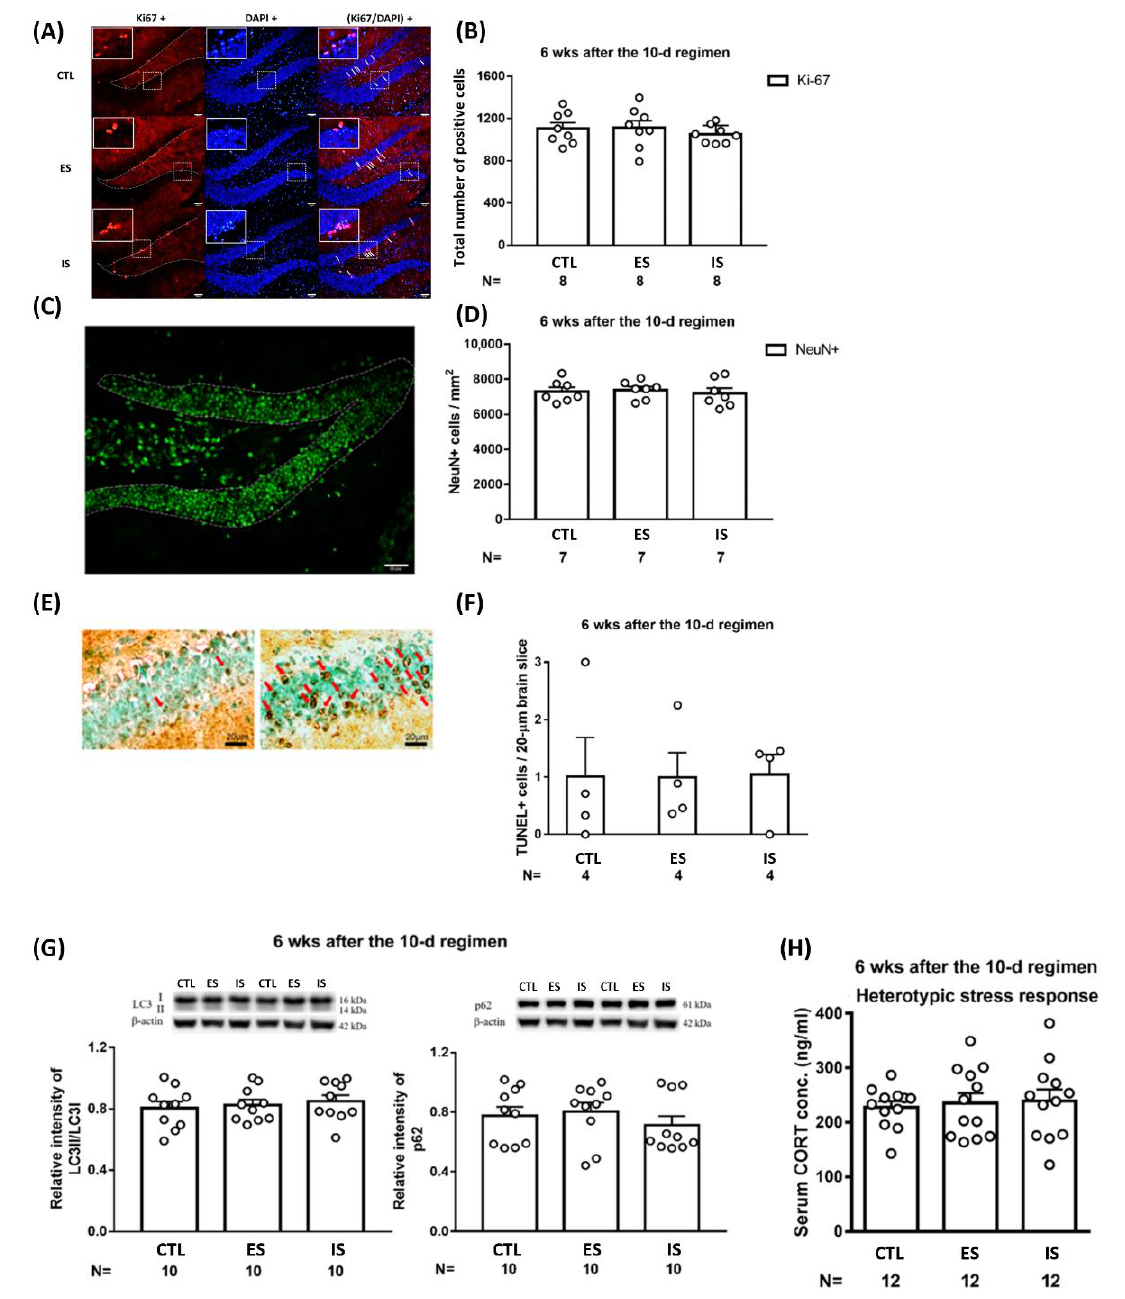
Figure 4. Long-term impact of the 10-day footshock stressor regimen on dorsal DG mitosis, neuronal density, autophagic flux; cells undergoing apoptotic death; and animals’ heterotypic stress-provoked CORT secretion. ( A ) Representative photomicrographs of Ki67 (red)-, DAPI (blue for depicting the border of pyramidal blades)-positive cells. Staining cells were counted positive only when their locations were at the border (dotted lines) of suprapyramidal and infrapyramidal blades. White arrows point to Ki67-positive cells. Scale bar = 50 µ m. ( B ) ES, IS, and control (CTL) mice demonstrated comparable mitosis in the dorsal DG at 6 weeks after the conclusion of the 10-day regimen. Data are plotted as mean ± SEM. ( C ) A representative photomicrograph of NeuN (green)-positive cells and dotted line-encircled area for gauging neuronal density. Scale bar = 50 µ m. ( D ) Three groups of mice had comparable neuronal density in the dorsal DG at 6 weeks after the conclusion of the 10-day regimen. Data are plotted as mean ± SEM. ( E ) Representative photomicrographs showing apoptotic cells (dark brown) in the dorsal DG of ES and kainic acid-infused (positive control) mice. ( F ) The